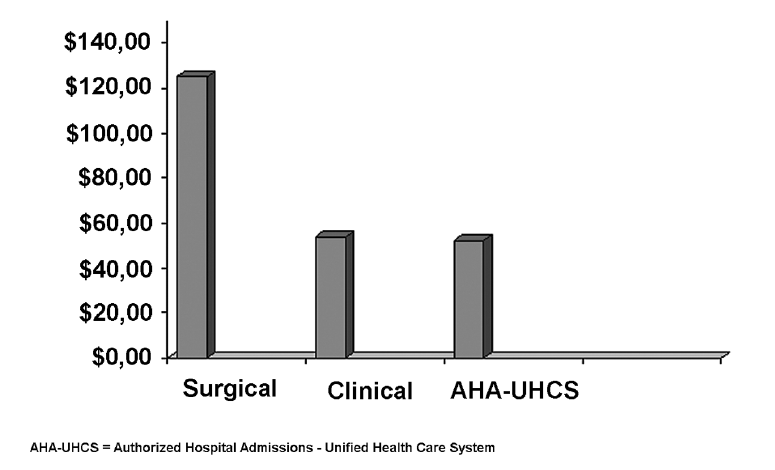
Figure 5 – Comparison between the value transferred by the Unified Health Care System for the surgical procedure (circumcision) and median costs of the clinical and surgical groups. AHA-UHCS = Authorized Hospital Admissions-Unified Health Care